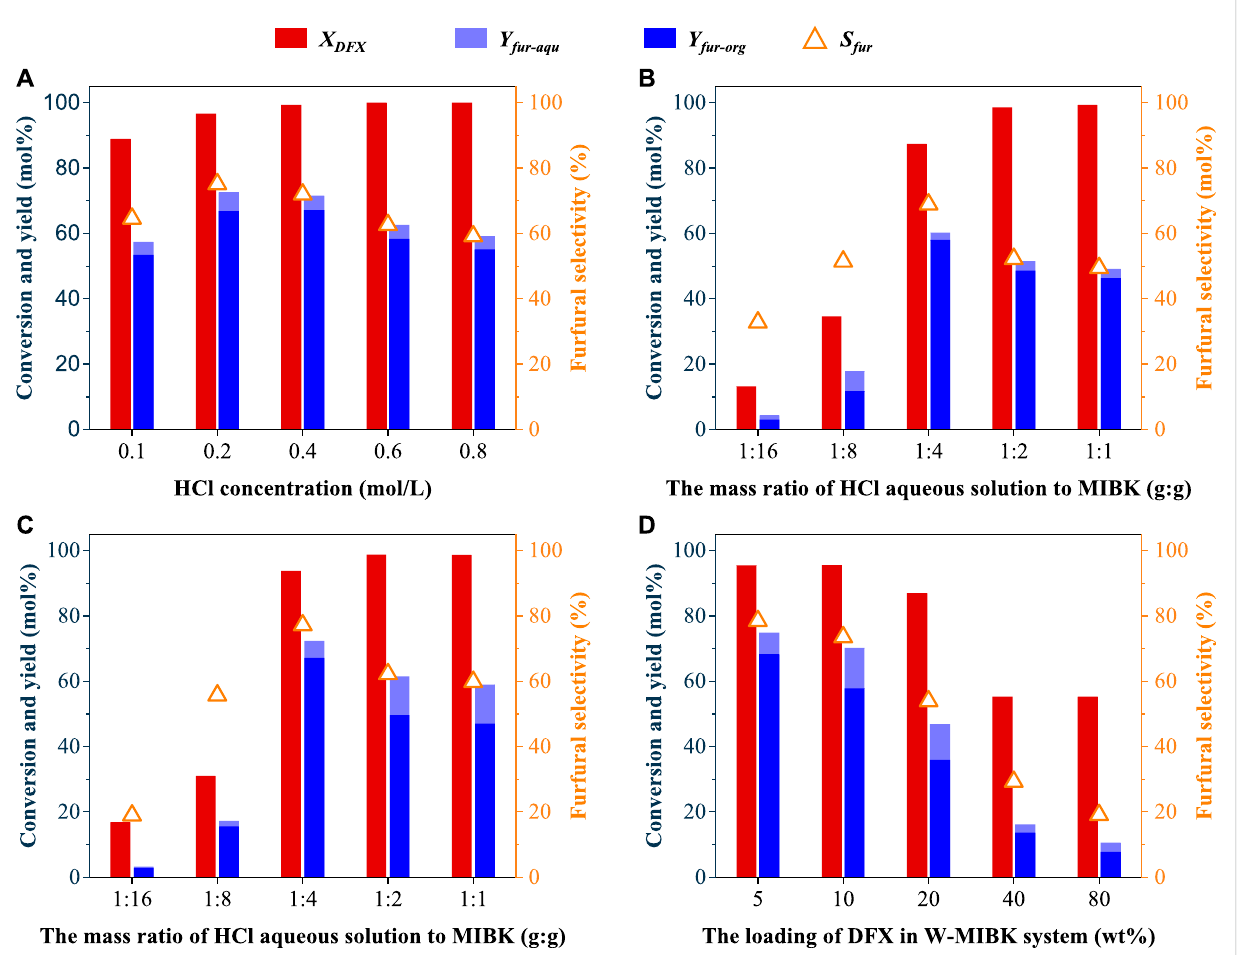
Effects of (A) acid concentration in aqueous phase, (B) and (C) solvent composition, and (D) DFX loading on the conversion ef fi ciency of DFX to furfural in theW-MIBK system. The stirring speed and total mass of solvents for all reactions were 600 rpm and 10 g, the acid concentration used in FiguresB~Dwas0.2 mol/L,andtheDFXloadingforFigure (A – C) was5 wt%.A1:4(wt:wt)massratioofHClaqueoussolutiontoorganicsolventwasused for Figure (A, D) . Other reaction conditions of (A) and (B) : 170 ° C, 30 min; (C, D) : 185 ° C, 10